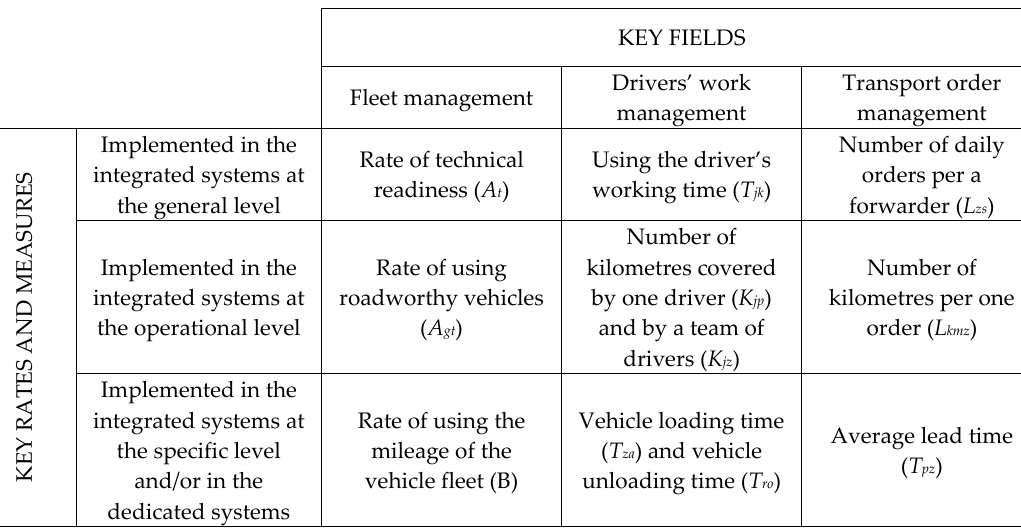
Figure 2. The fields of operational activities undertaken by the analysed enterprises that prove to be the most sensitive in terms of the support provided by IT systems.